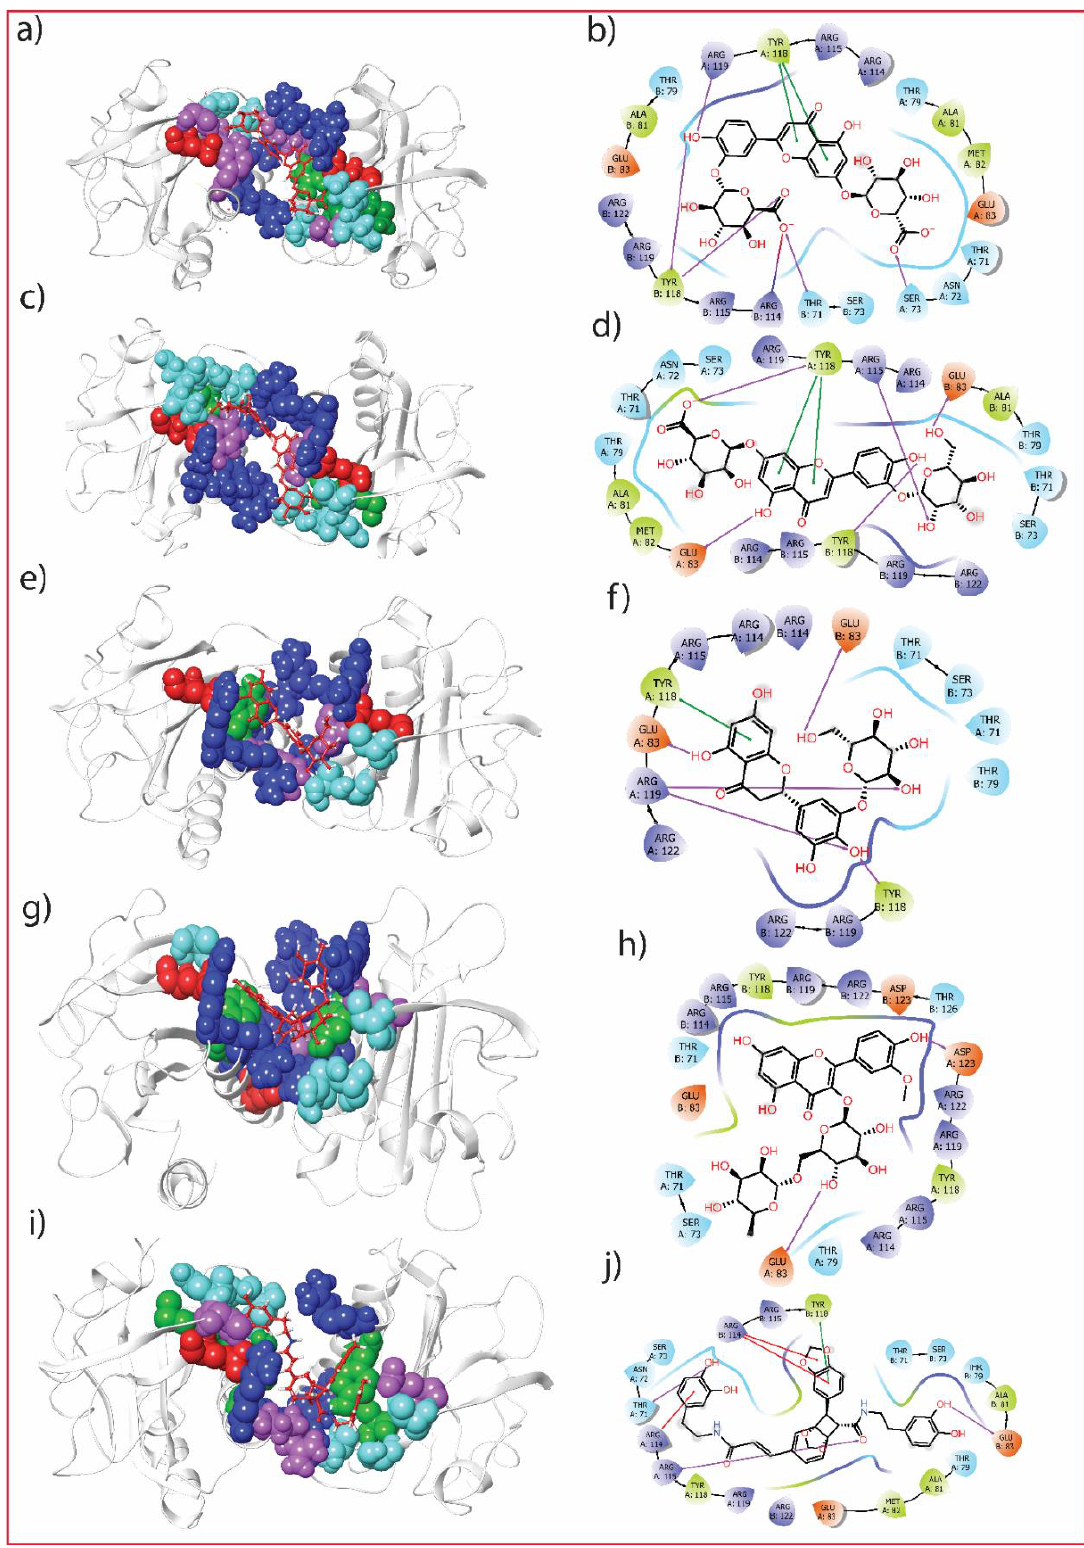
Figure 2. 3D and 2D illustration of best poses of the selected top five P. lanceolata compounds: ( a , b ) Luteolin 7,3′ -diglucuronide, ( c , d ) Luteolin 7-glucuronide- 3′ -glucoside, ( e , f ) Plantagoside, ( g , h ) Nar- cissoside, and ( i , j ) (alphaE,8S,9R)-N-(3,4-Dihydroxyphenethyl)-8-[(3,4-dihydroxyphenethyl)car-